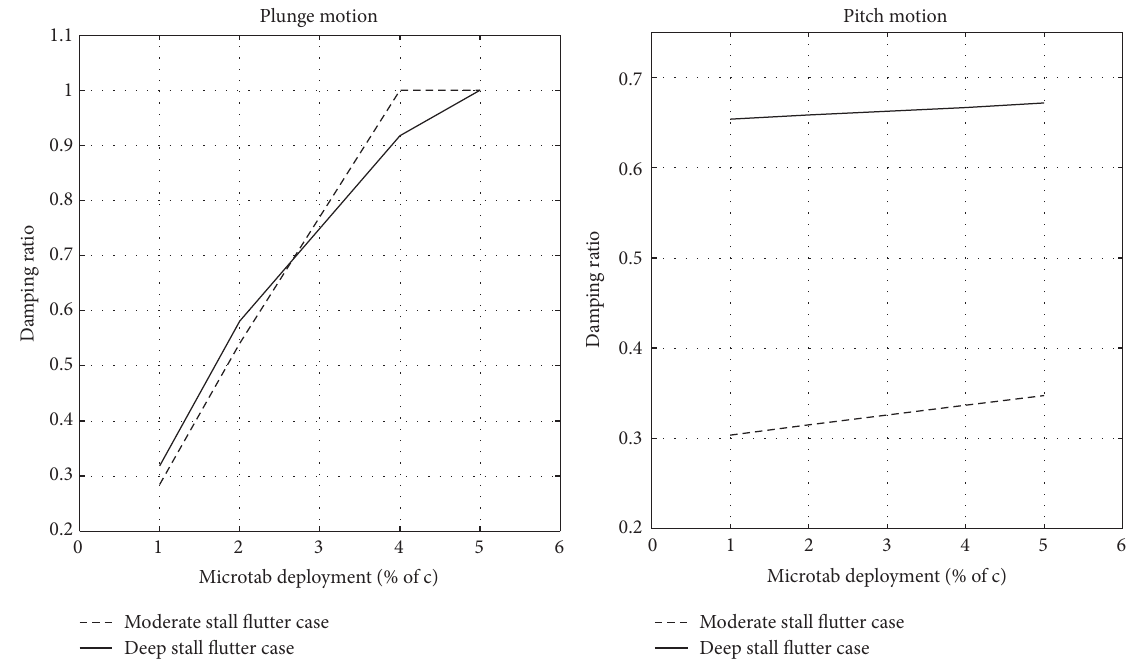
Figure 11: Damping ratios versus microtab limitation for moderate/deep stall flutter